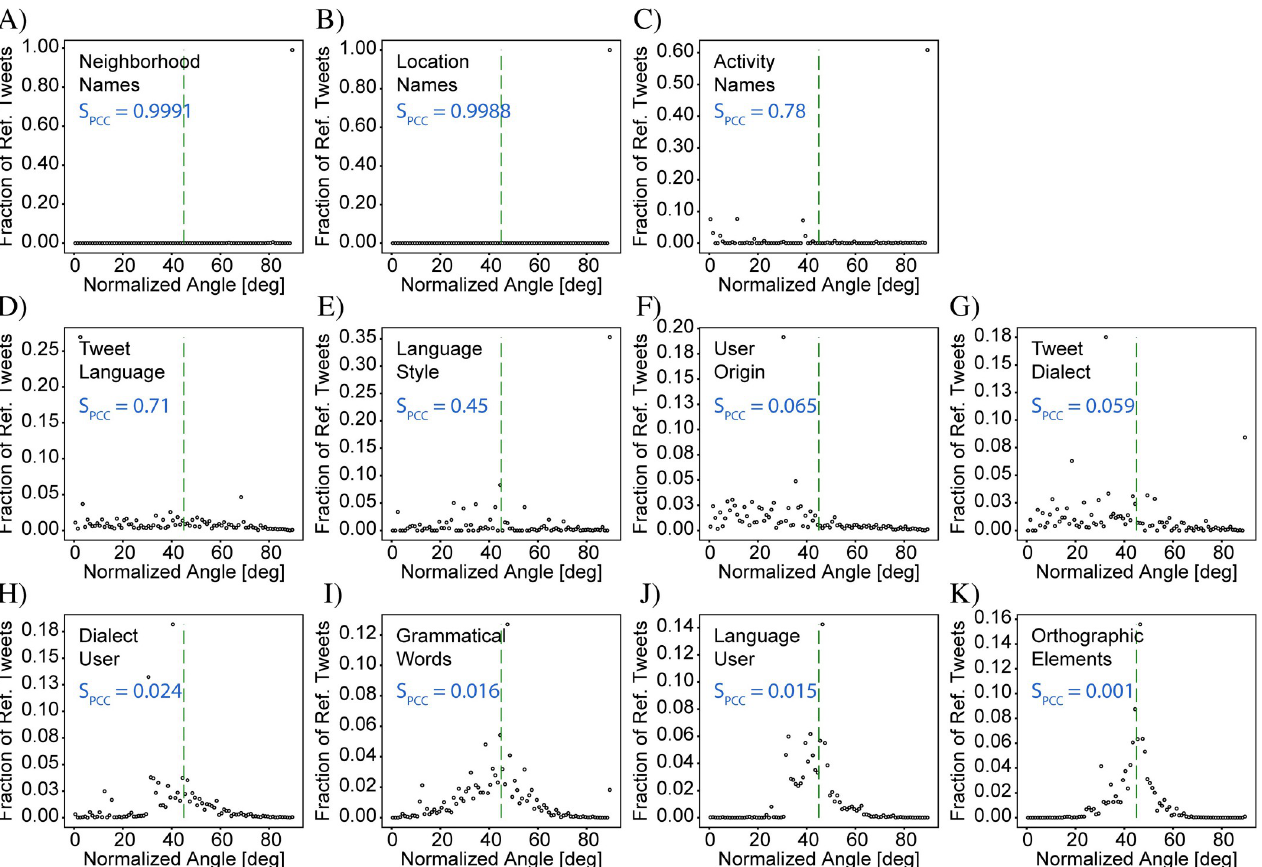
Fig 14. Normalized angle histogram plots for the eleven categories of sociolinguistic features. Plots are arranged in order of signal strength (S PCC ) from left to right and from up to down. The three rows of graphs correspond to three categories of signal strength, with very-strong-signal cases having perfectly flat histograms, intermediate-strength-signal cases having a very wide distribution, and low-strength-signal cases exhibiting a normal distribution. The correspondence between the shape of the histograms and the signal strength enables an intuitive interpretation of the various cases.